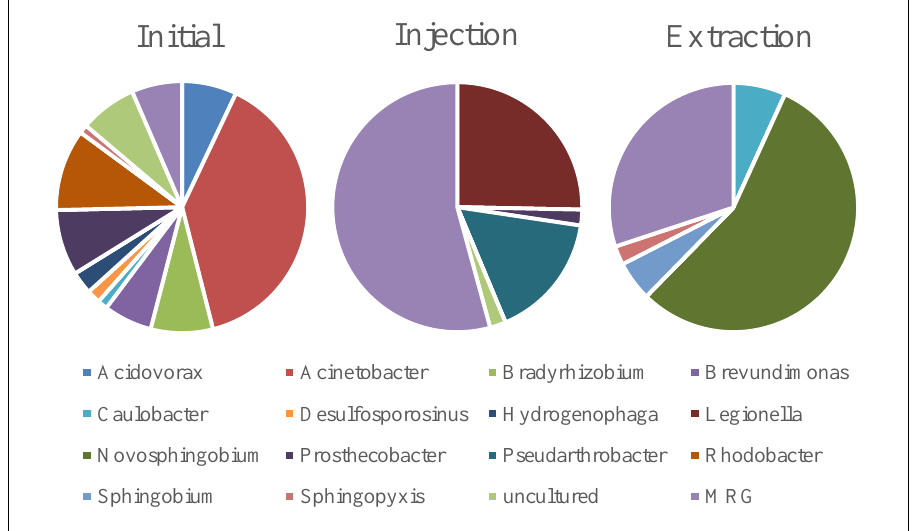
Figure 3. Taxonomic information (genus level) based on 16S rRNA gene sequences of the indigenous bacteria during Site A's treatment